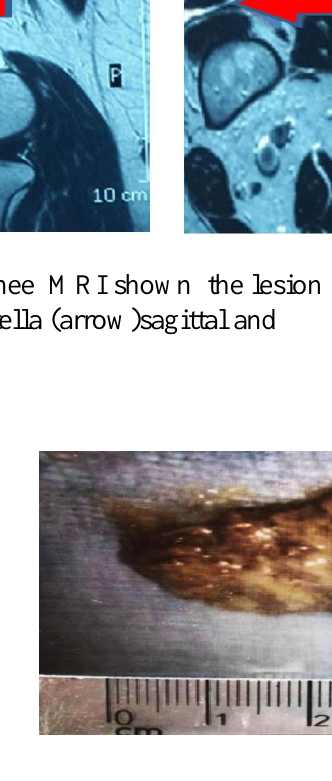
Figure 3: Gross appearance of the